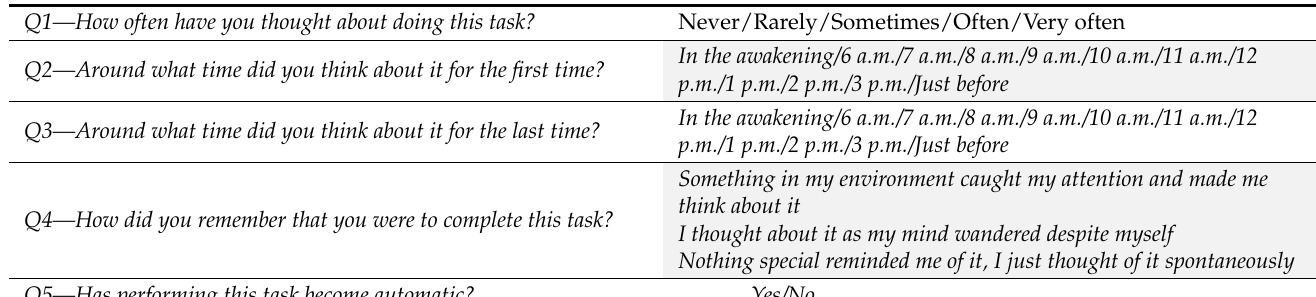
Table 3. Prospective memory survey: questions and